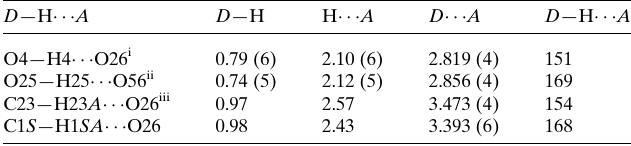
Table 1 Hydrogen-bond geometry (A˚ , (cid:5) ) for